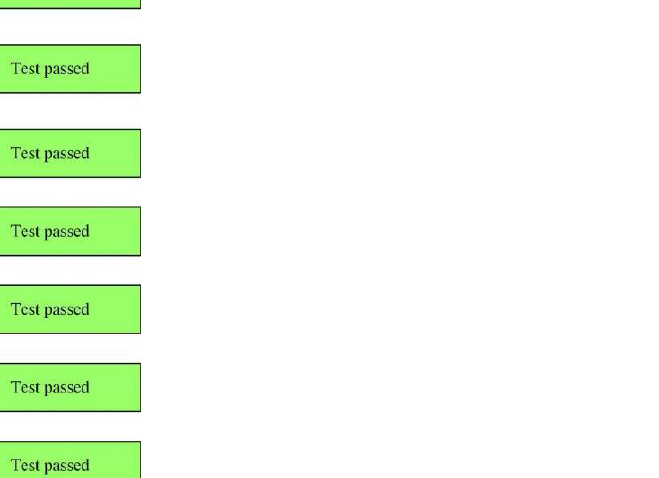
Figure 6. Testing of functions and services (drawn according to the test results after research and design combined with data).